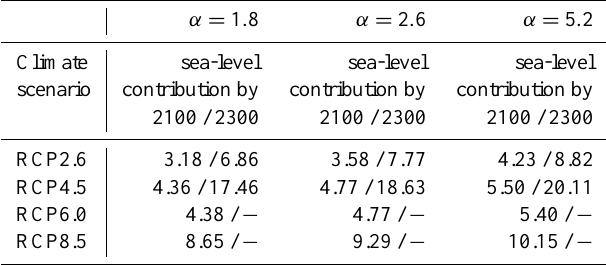
Table 5. Sensitivity of future sea-level contribution from the Green- land ice sheet to the parameterisation of ocean warming-induced discharge increase. Values are ensemble averages with respect to the year 2000, given in cms.l.e. α = 1 . 8 α = 2 . 6 α = 5 . 2 Climate sea-level sea-level sea-level scenario contribution by contribution by contribution by 2100 / 2300 2100 / 2300 2100 /